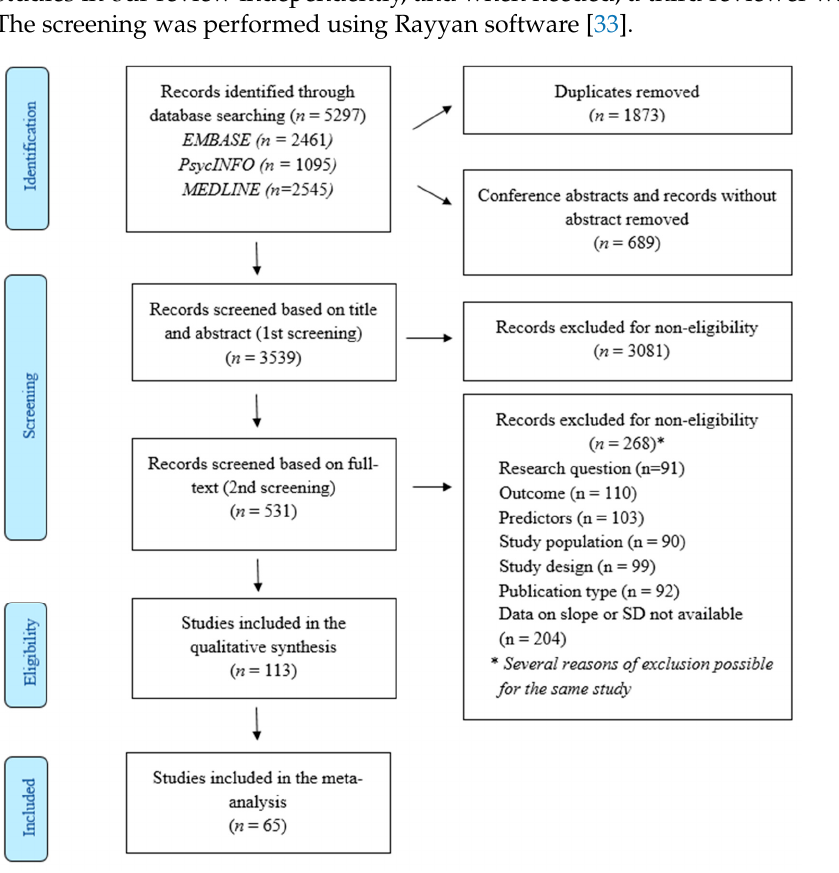
Figure 1. Flow-chart of the included studies.